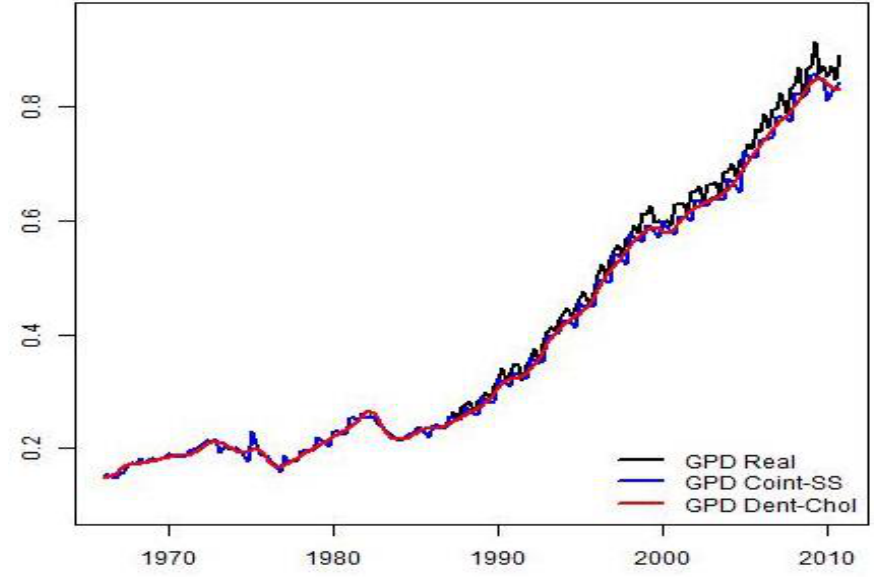
Figure 5. Real PIB and PIB predictions using the Cointegration-SS and the Denton–Cholette